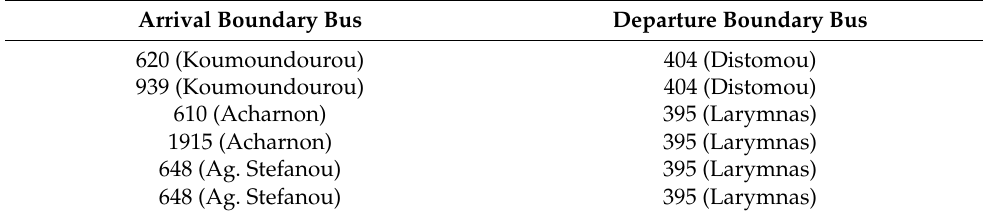
Table 1. Transmission lines and boundary buses of the 400kV transmission corridor. Arrival Boundary